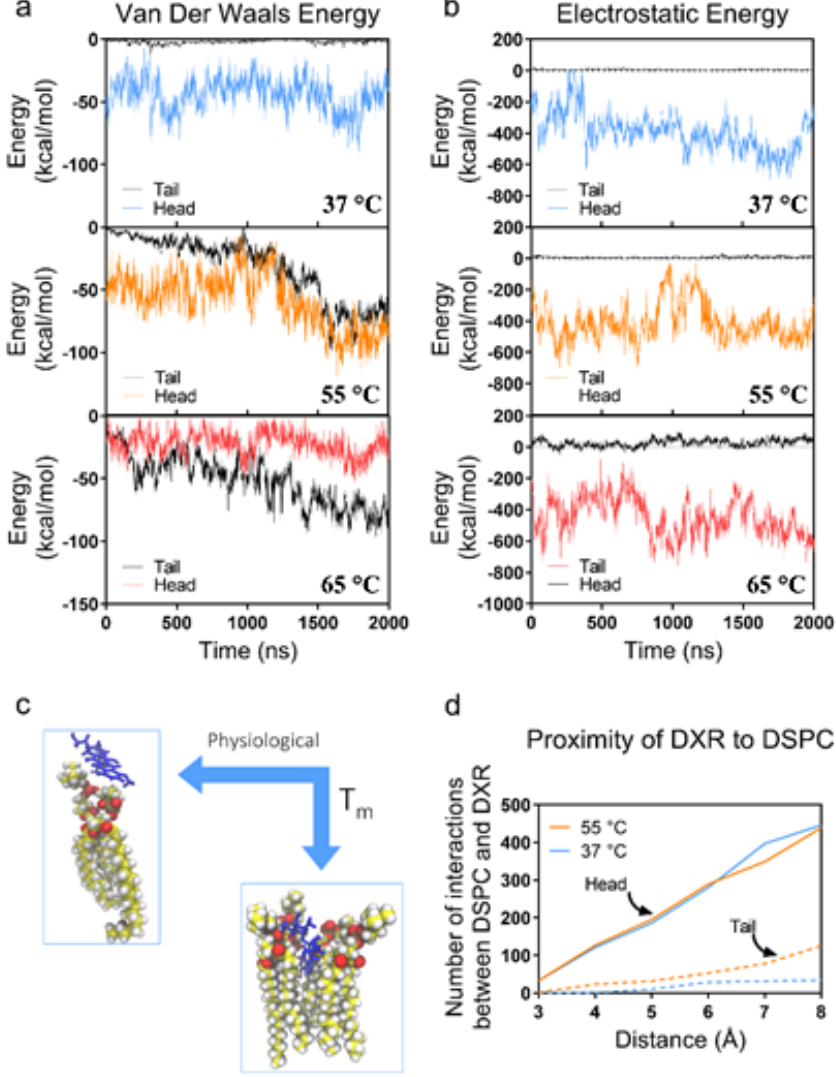
Figure 4. Atomic level simulations. Analysis of ( a ) long-range VdW and ( b ) short-range electrostatic forces. At all temperatures, the DXR molecules are attracted to the negatively charged lipid heads, however only as the membrane acquires a more liquid-state ( ≥ T m ) does the DXR shows any attraction or interaction to the lipid tails. ( c ) The simulations depict adsorption of DXR to the membrane below T m , however at and above T m DXR infiltrates into the membrane. ( d ) Most DXR atoms are located within 5–8 Å of DSPC, insinuating a more additive and transient non-covalent